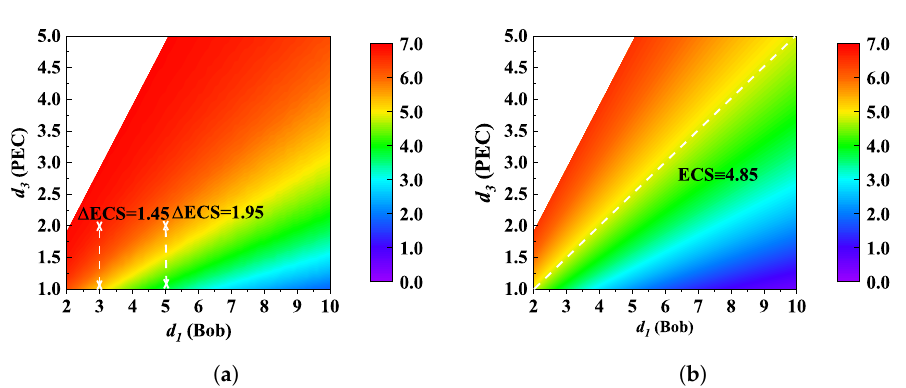
Figure 5. Ergodic secrecy capacity (ESC) as a function of d 1 (Alice–Bob) and d 3 (Alice–PEC) for ( a ) non-colluding eavesdroppers and ( b ) colluding eavesdroppers. Other parameters are given by: G = 25 dBi; N = 3; f = 300 GHz; P = − 10 dBm; R S = 15 m; and λ p = 0.015.